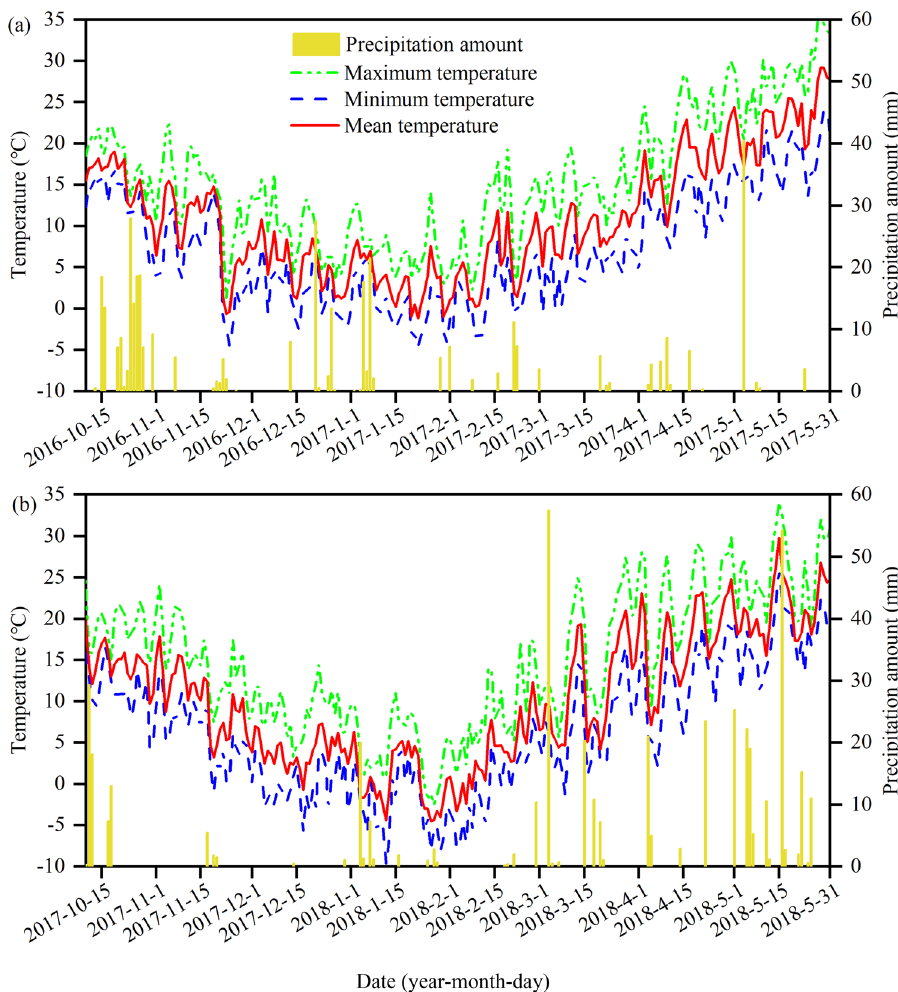
Figure 1. Daily mean, minimum, and maximum temperature and precipitation amount during the wheat- growing seasons of 2016–2017 and 2017–2018 ( a and b).